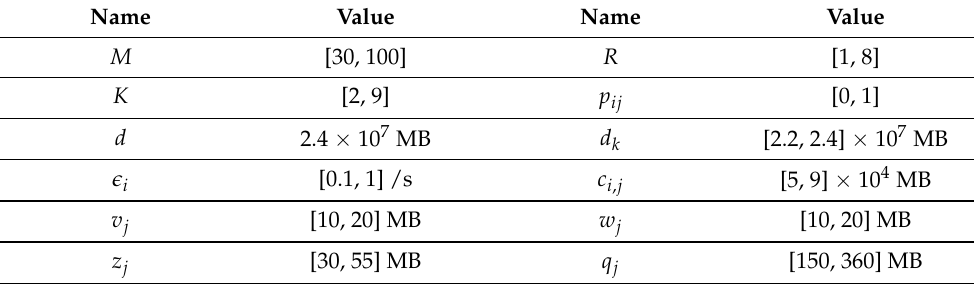
Table 1. The parameters used in simulations and their default